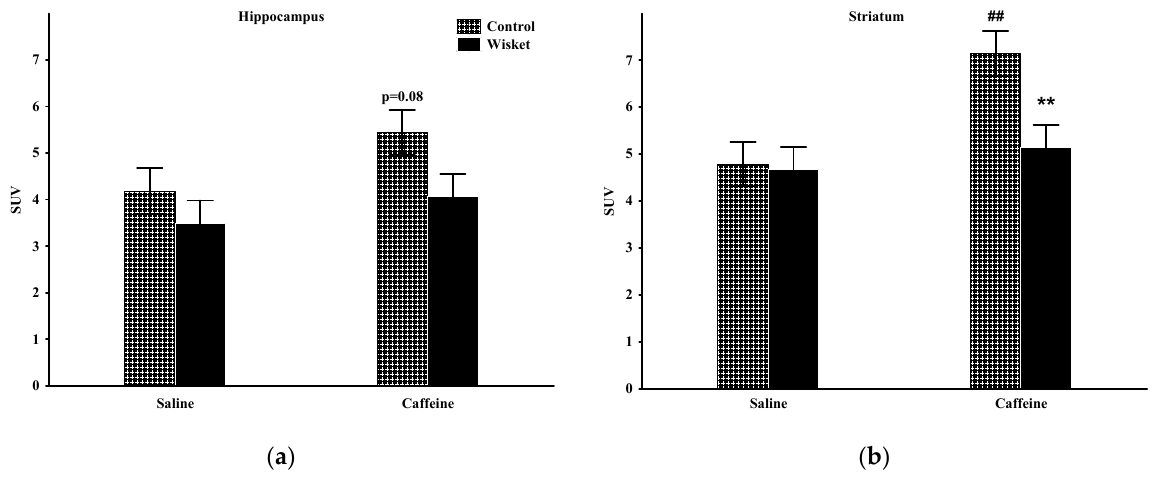
Figure 3. The mean 18 F-FDG PET SUV with standard error bars in the hippocampus ( a ) and striatum ( b ) in control and Wisket animals with saline/caffeine applied one day before PET scan. Symbols denote significant differences between the two groups (**) compared to saline (##); p < 0.01 with two symbols.